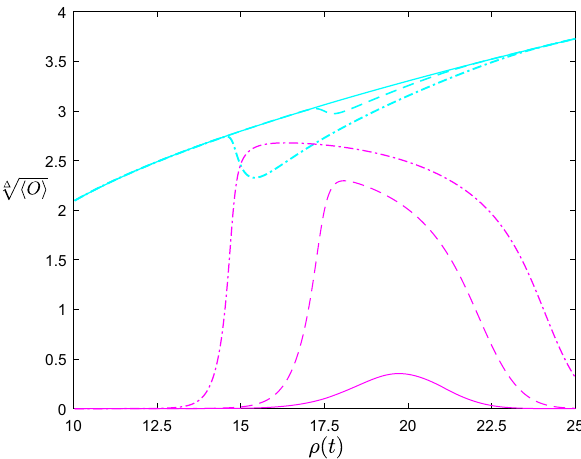
Fig. 4 The values of condensates for s-wave and p-wave orders in three quenching processes with v = 0 . 00005 and different values of q p . The horizontal axis show the linearly time dependent charge density ρ( t ) , while the vertical axis show the condensate values (cid:9) curves denote for the s-wave order and magenta curves denote for the p- wave order. The dotted dashed lines, dashed lines and solid lines denote the three different processes with q p = 0 . 7189, 0 . 7187 and 0 . 7186